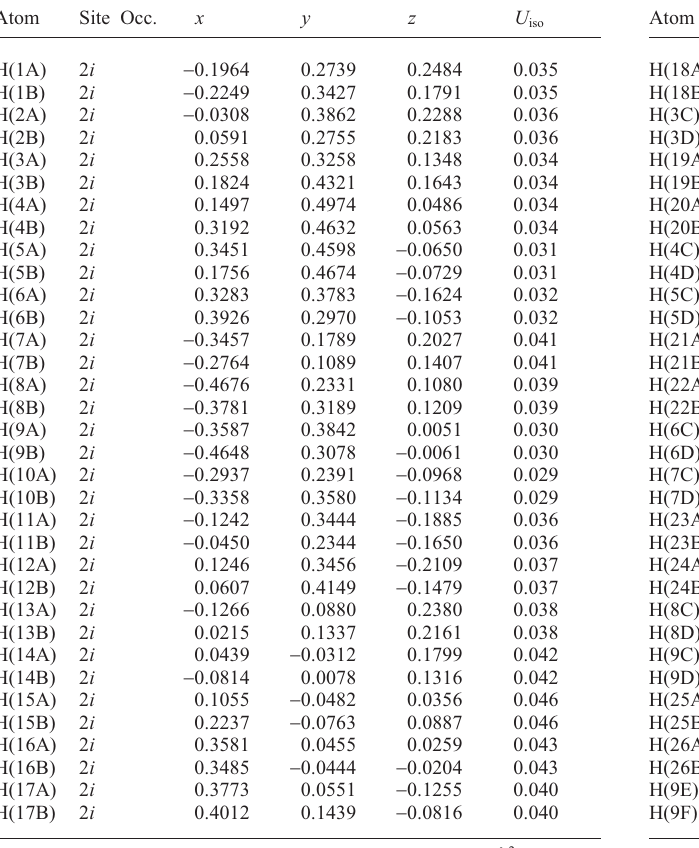
Table 3. Atomic coordinates and displacement parameters (in Å 2 ) . Atom Site